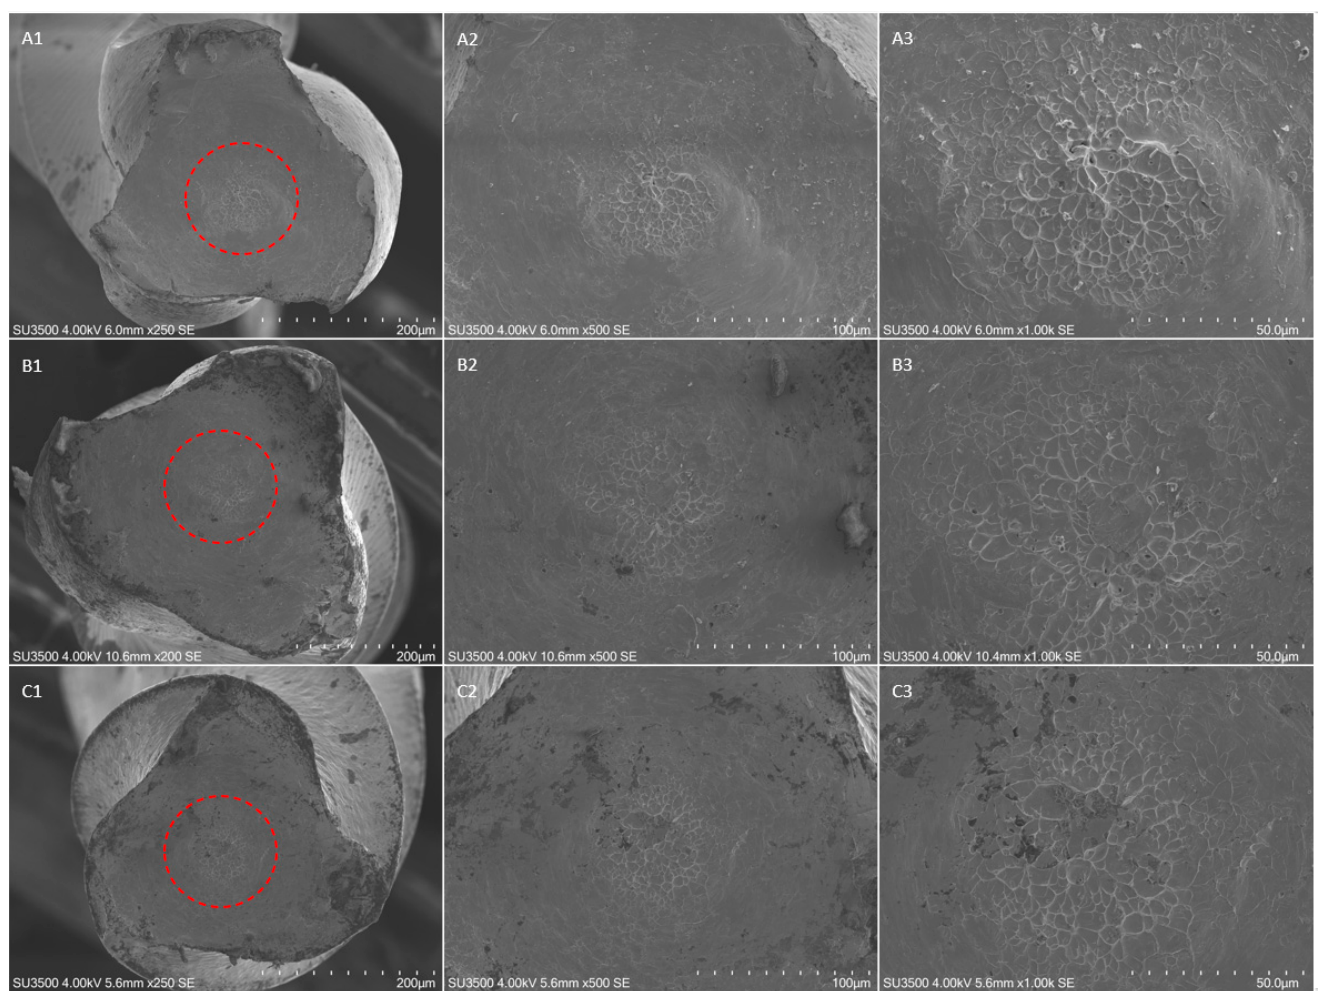
Figure 4. SEM images of fractured surface of three samples of HeroShaper 25/04 in a transversal view at different magnification after torsional fatigue testing. Figures represent SEM images of instruments fractured after torsional test performed with a straight insertion in the artificial canal, respectively at 250x, 500x and 1000x magnification; ( B1-B3 ) SEM images, respectively at 200x, 500x and 1000x magnification, after torsional test performed with an insertion angle of 10°; ( C1-C3 ) SEM images, respectively at 250x, 500x and 1000x magnification, after torsional test performed with an insertion angle of 20°. The concentric circular abrasion marks and fibrous dimples near the center of rotation evidenced by the red circumferential lines are clearly represented in all samples despite the different angle of insertion.